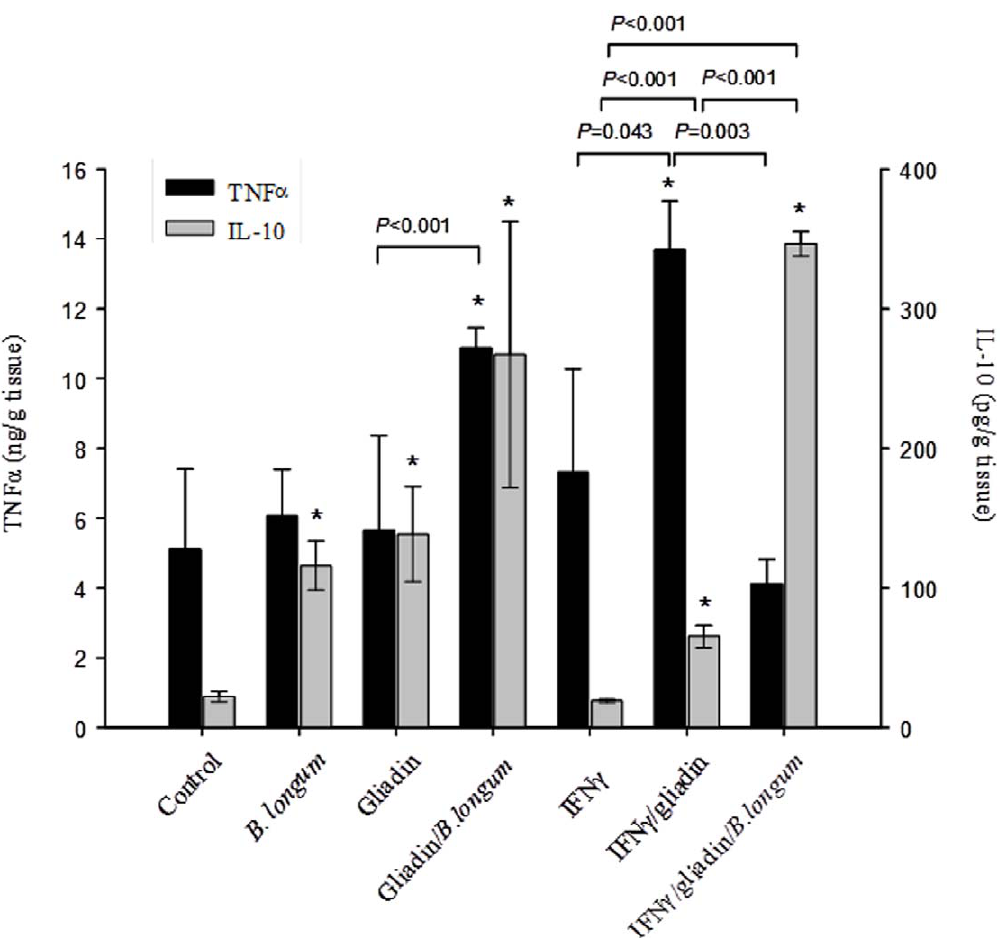
Figure 3. Tumour necrosis factor (TNF)- a and interleukine (IL)-10 production in jejunal tissue sections of rats after different treatments. The results are expressed as mean 6 standard deviation (n=6). *Indicates statistically significant ( P , 0.05) differences compared to the controls; bars indicate significant differences between the specific pair comparisons as determined by applying the Student t test. doi:10.1371/journal.pone.0030744.g003 NF- k B subunit relA in complex with PPAR- c [35], while other that the B. longum strain used in this study only causes a transient commensal bacteria block NF k B at more proximal steps, activation of NF-kB mRNA expression without enhancing the inhibiting ubiquitination and proteolytic inactivation of the final production of inflammatory mediators such as TNF- a in the endogenous NF- k B inhibitor I k B [36]. Therefore, it is possible enteropathy animal model. Table 2. Leukocyte percentages (%) in peripheral blood of different rat experimental groups.